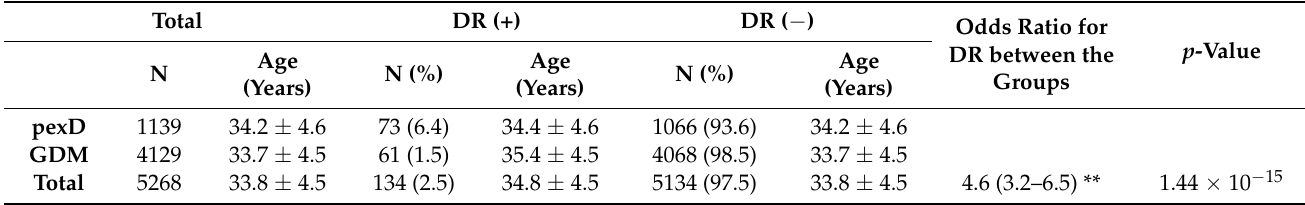
Table 1. The prevalence of DR from the Japanese claim database cohort.